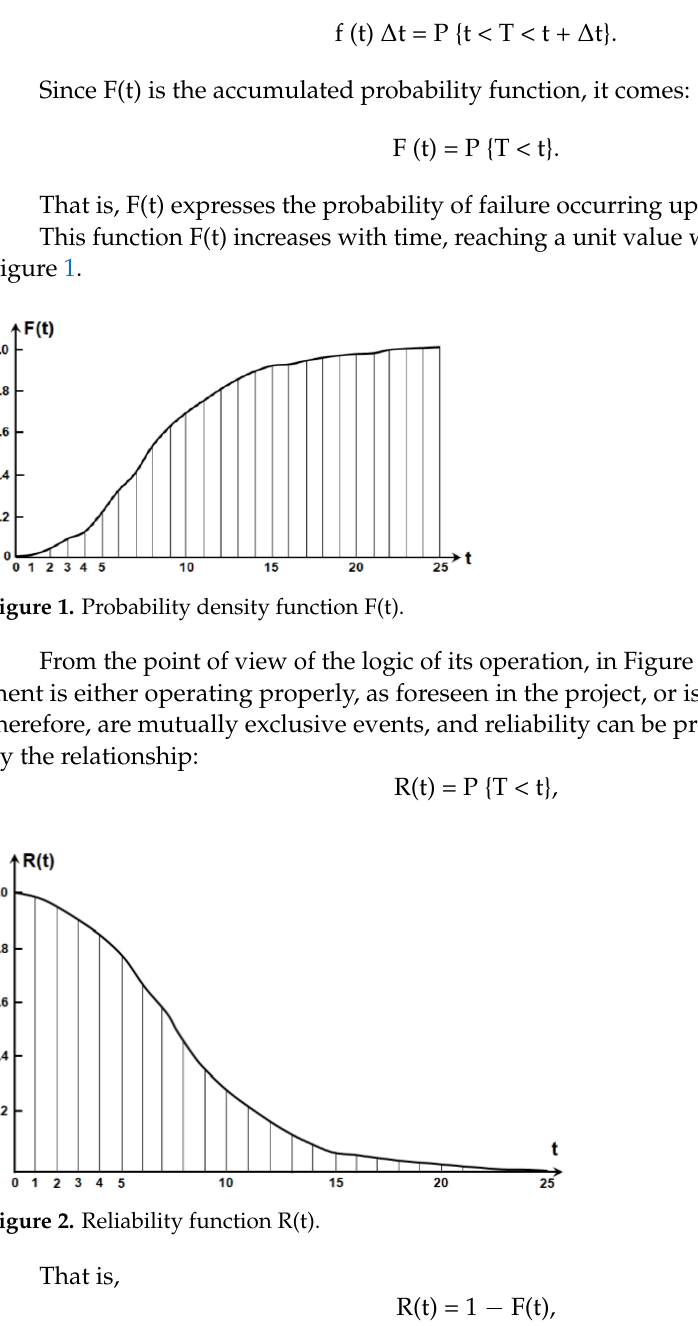
Figure 2. Reliability function R(t).